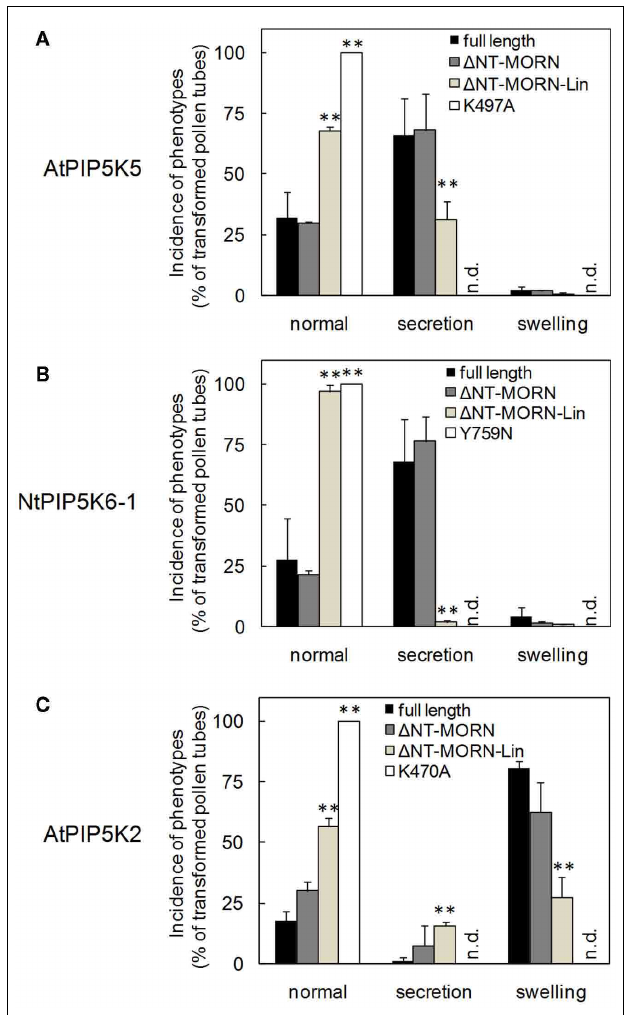
FIGURE 4 | Deletion of N-terminal domains abolishes effects of truncated variants ofAtPIP5K5, NtPIP5K6-1, orAtPIP5K2 on pollen tube growth. The effects of overexpression of truncated variants of AtPIP5K5, NtPIP5K6-1, or AtPIP5K2 on pollen tube growth were analyzed (gray bars, as indicated). Phenotypes were categorized as normal, as secretion phenotypes (wavy growth, tip branching and protoplast trapping), or as tip swelling. Full-length enzymes (black bars) and catalytically inactive variants (white bars) were used as controls. (A) AtPIP5K5 and derived proteins; (B) NtPIP5K6-1 and derived proteins; (C) AtPIP5K2 and derived proteins. Data are means ± SD from four independent transformation experiments and represent ≥ 300 transgenic pollen tubes observed for each construct. n.d., Not detected.The asterisks indicate a significant difference from the full-length control within each category according to a Student’s t test (** p <